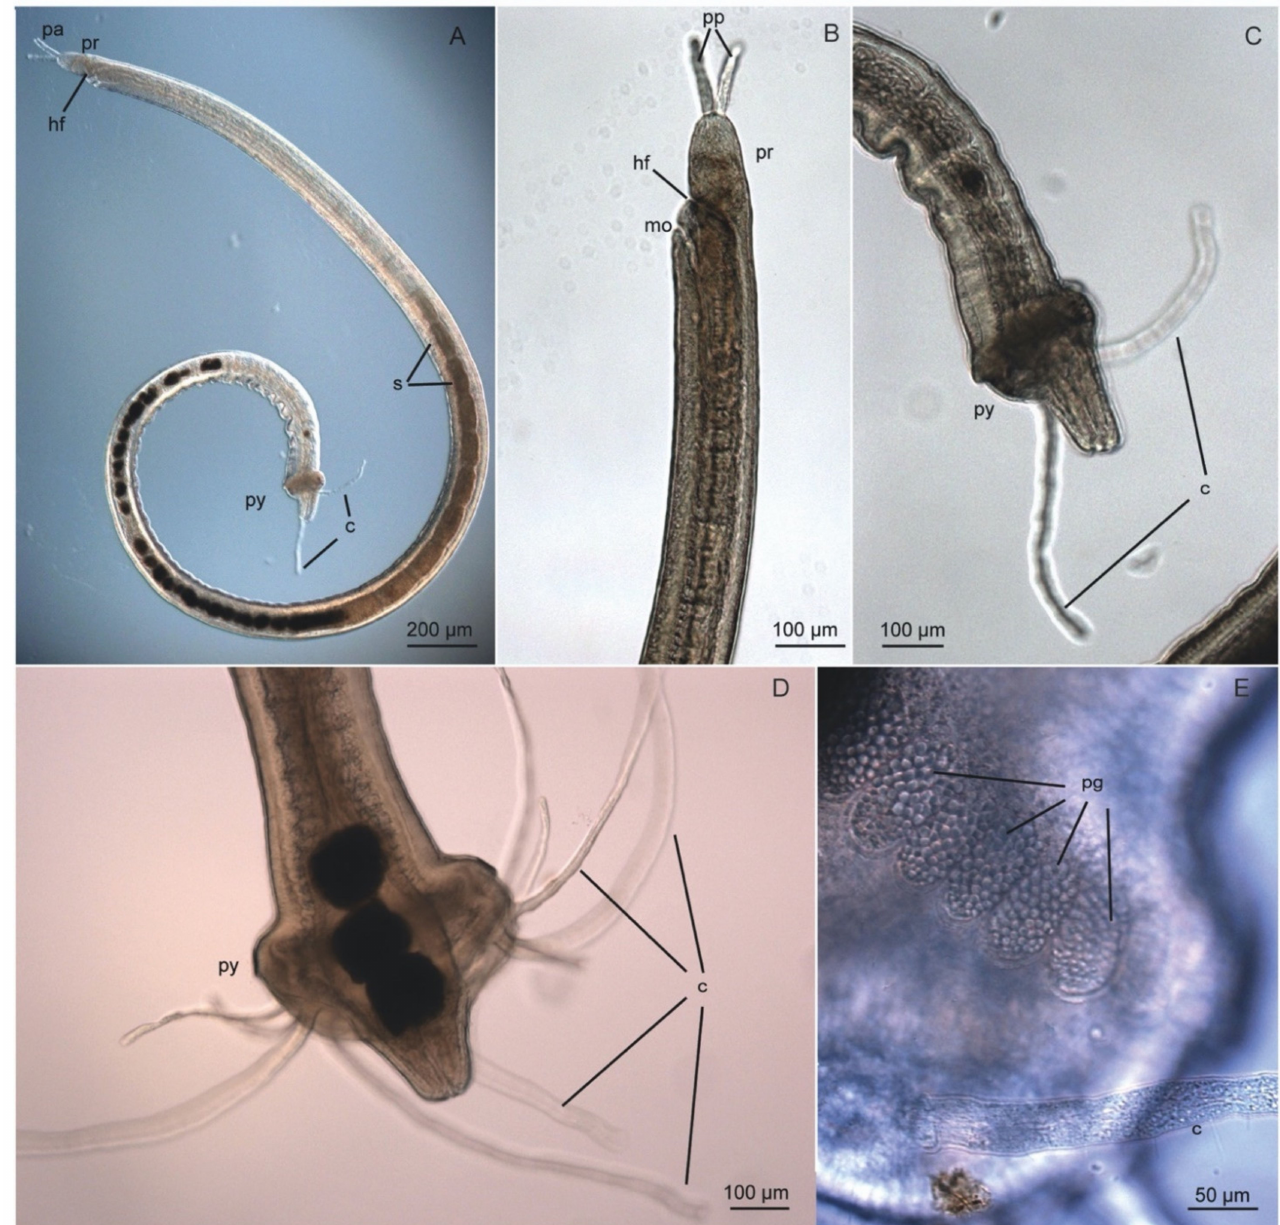
Figure 9. Morphology of Polygordius. ( A – C ) Polygordius sp. (S ã o Sebasti ã o Island, S ã o Paulo, Brazil). ( A ) Entire body. ( B ) Anterior end. ( C ) Posterior end. ( D , E ) Polygordius leo (S ã o Sebasti ã o Island, S ã o Paulo, Brazil). ( D ) Details of pygidium ( E ) Adhesive pygidial glands. Abbreviations: c, cirrus; hf, head fold; mo, mounth opening; pa, palps; pg, pygidial glands; pp, paired palps, pr, prostomium; py, pygidial lobe; s, segment. muscular